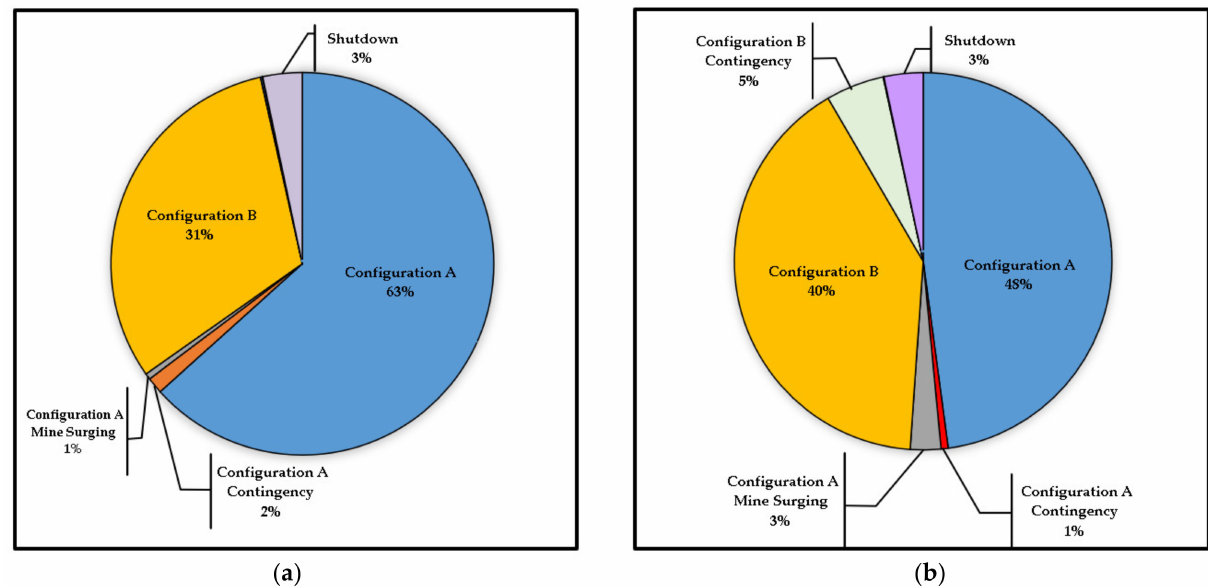
Figure 10. Time distribution of operational modes in response to geometallurgical units with CN con- sumption variability for ( a ) target ore stockpile level critical at 10,000 t and LCC threshold of 2000 t, and ( b ) an enhanced configuration using a critical value of 6000 t and a target total stockpile level of 4000